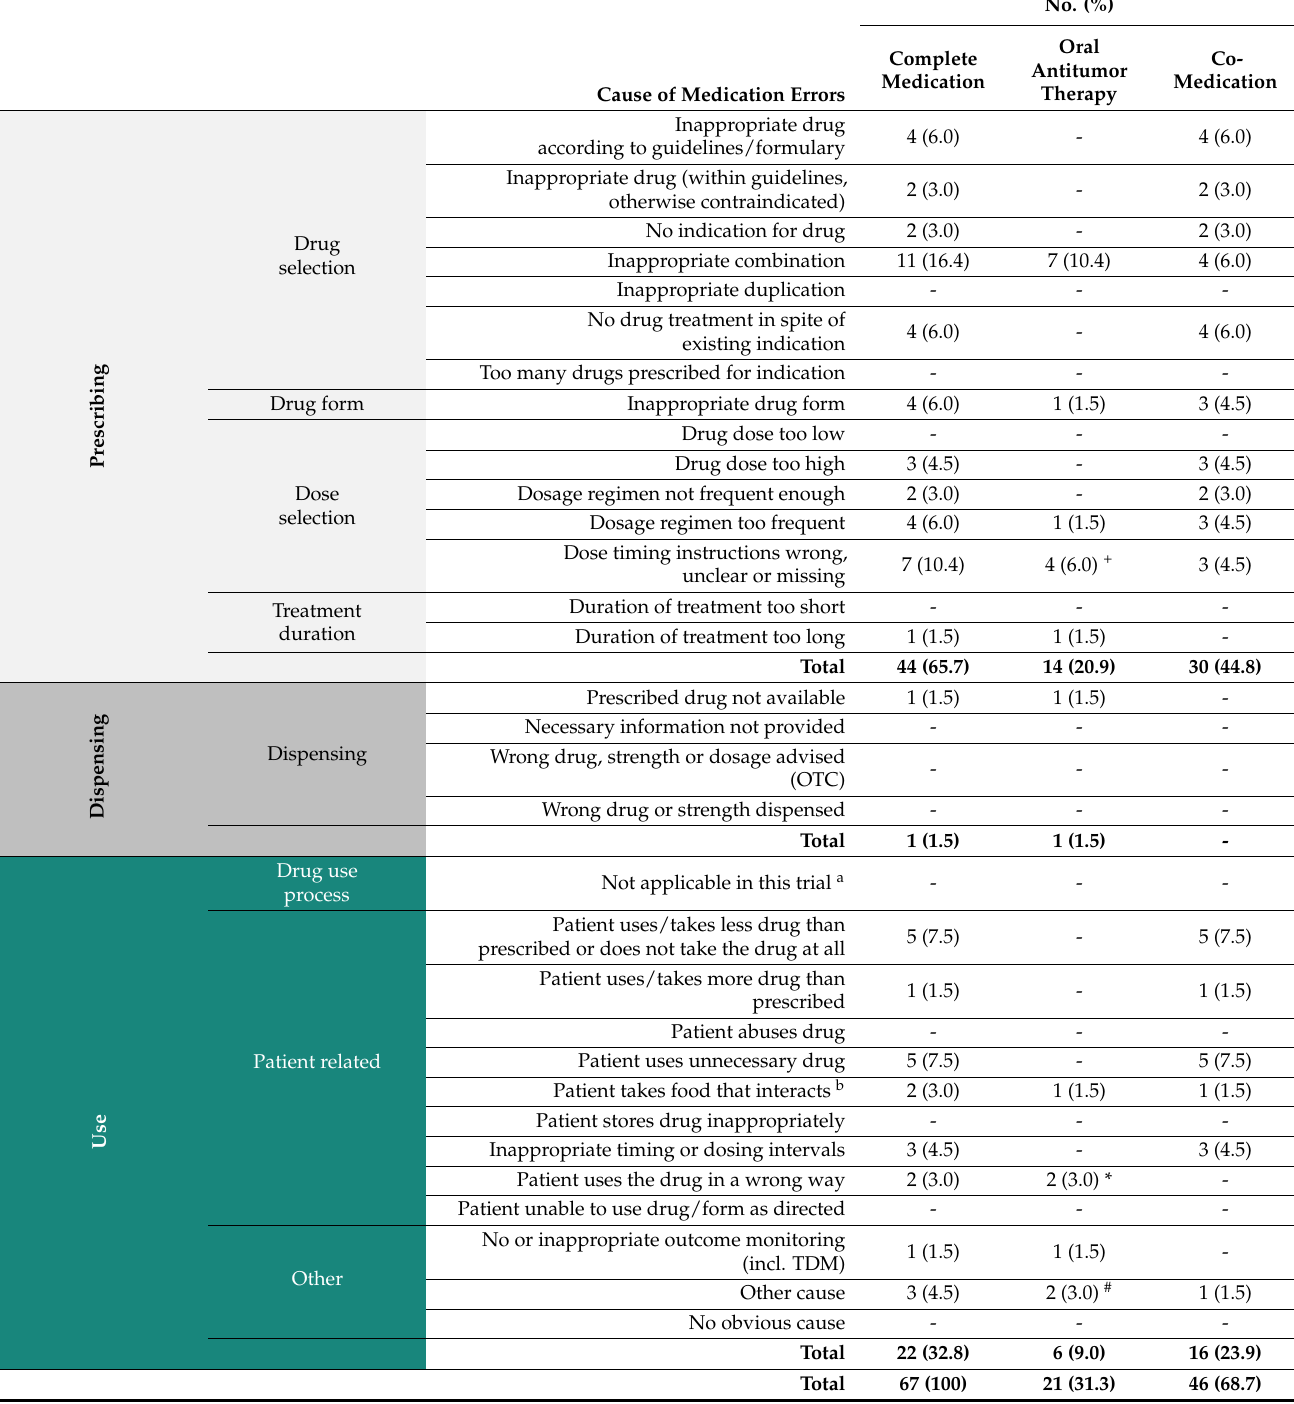
Table 2. Number of medication errors in patients with PC or RCC on new oral antitumor drugs classified by PCNE V8.02